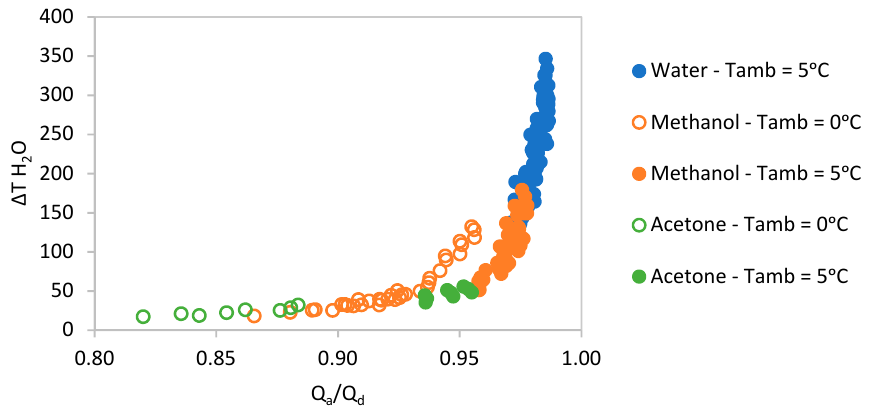
Figure 4. Water, methanol and acetone pairs performance for T amb = 5 ◦ C, T a = 8,9,10 ◦ C and T d = 13,14,15 ◦ C.